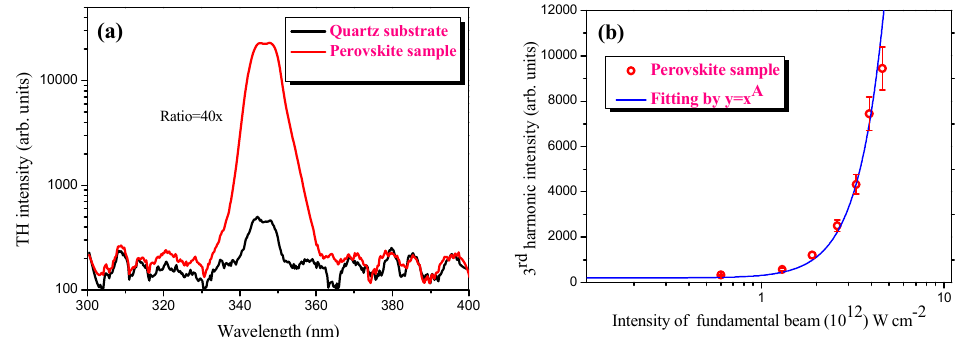
Figure 3. ( a ) Comparative log − scale spectra of third harmonic signal generated from pure quartz (black solid curve), and mixed perovskite (red-solid curve) using 1030 nm 38 fs laser pulses. ( b ) Log − scale dependence of third harmonic signal generated in the mixed perovskite on the intensity of the fundamental laser beam. The cubic (A = 3) dependence of the third harmonic intensity on the intensity of the fundamental laser pulses was